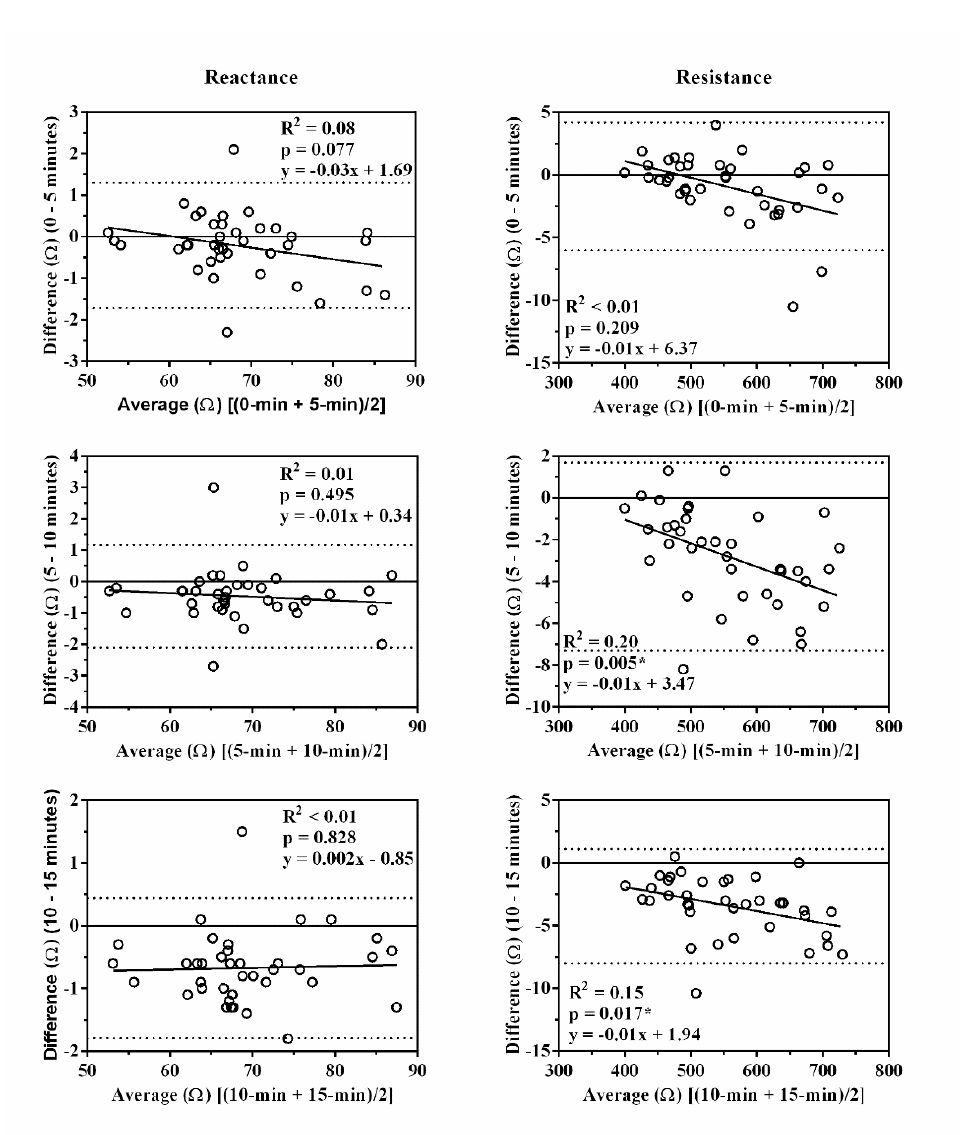
Fig. 4: Bland and Altman plots of individual differences for the effect of time since transitioning from a vertical to a supine position on reactance (left side) and resistance (right side) (N = 38). The solid line represents a mean difference (bias) of zero. The dashed lines denote the upper and lower limits-of-agreement (bias ± [1.96×SD of the bias]). R 2 represents the amount of variance explained by the average resistance or reactance. *p<0.05 significant systematic